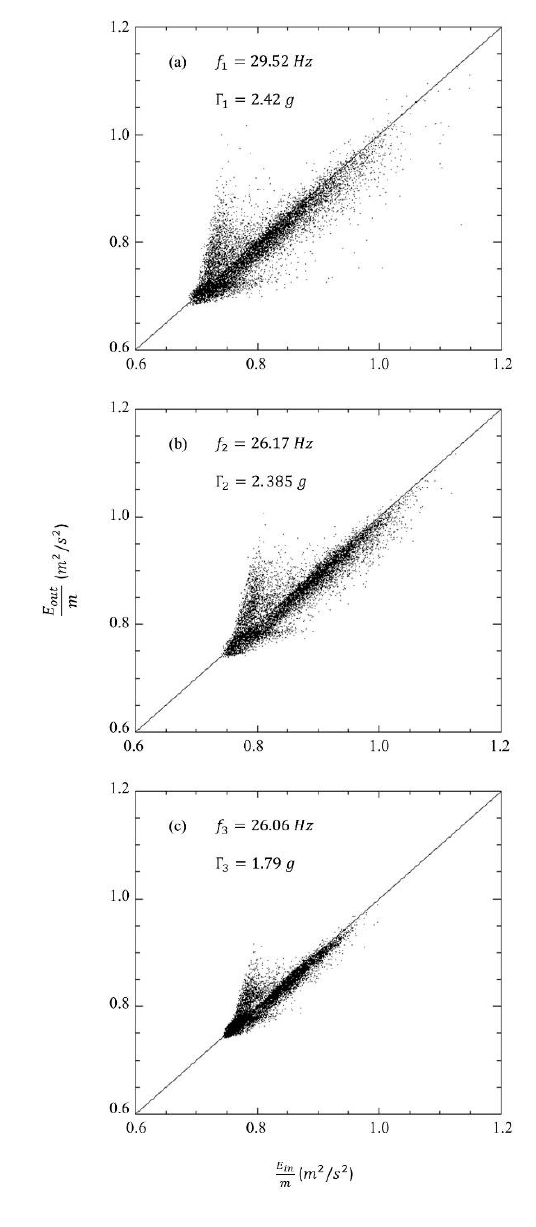
Fig. 5. Normalized mechanical energy after collision 𝐸 𝑜𝑢𝑡 against the normalized mechanical energy before collisions 𝐸 𝑖𝑛 in the center of mass frame; Parameters are as follows ： 𝑚 (a) 𝑓 1 = 29.52 𝐻𝑧 , Γ 1 = 2.42 𝑔 ; (b) 𝑓 2 = 26.17 𝐻𝑧 , Γ 2 = 2.385 𝑔 ; (c) 𝑓 3 = 26.06 𝐻𝑧 , Γ 3 = 1.79 𝑔